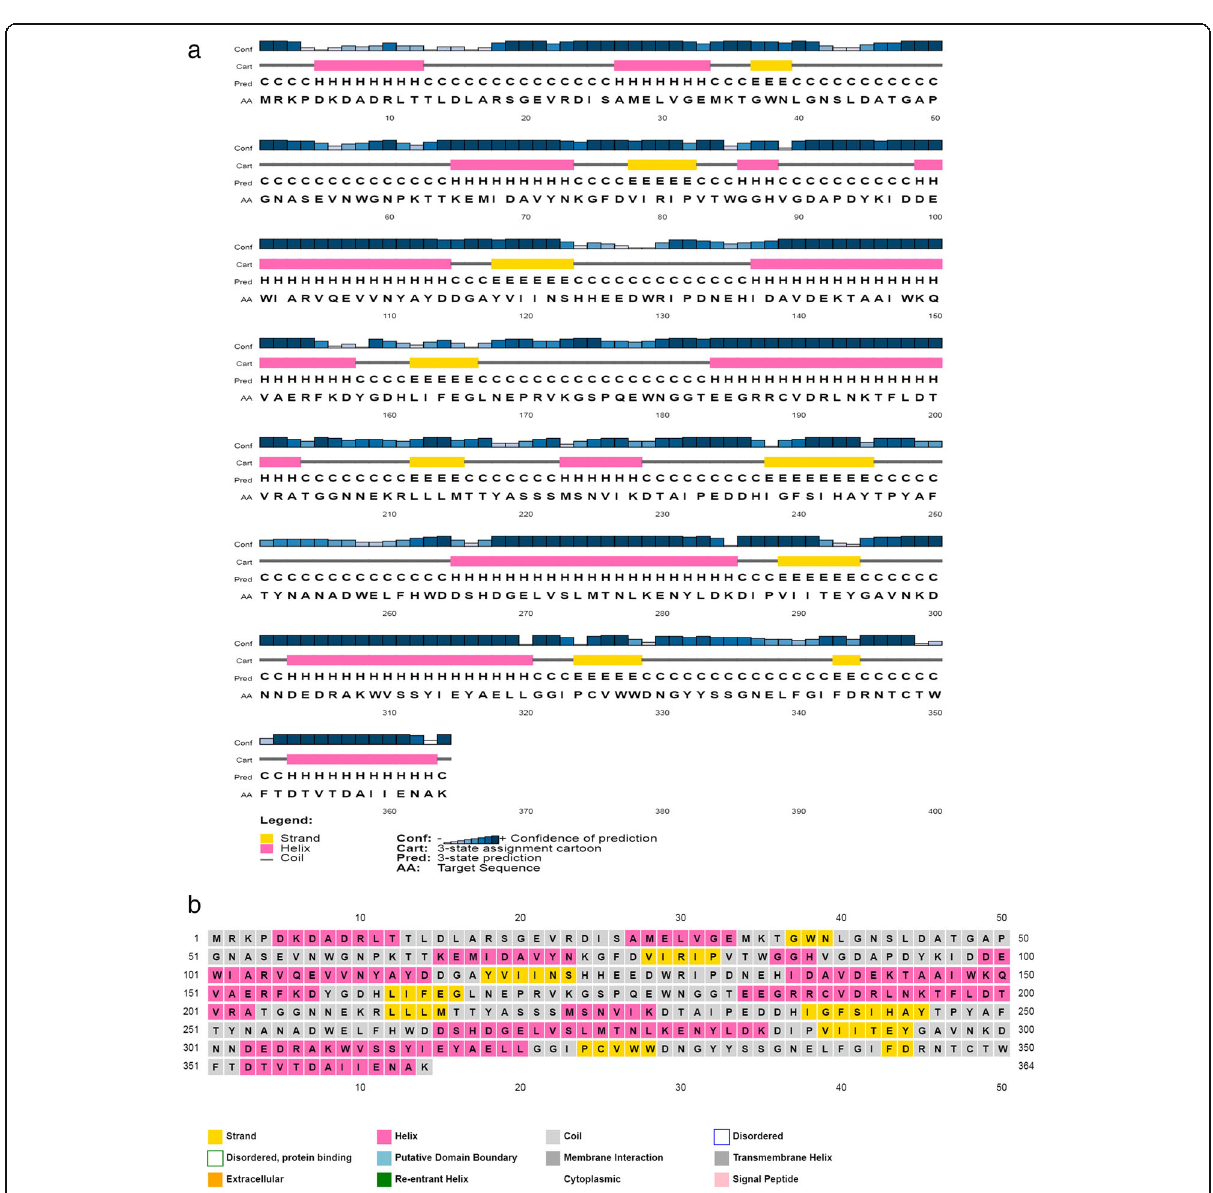
Fig. 3 Secondary structure map ( a ) and graphical representation of the predicted secondary structures present within the protein P23660 ( b ) attained by PSIPRED (The pink blocks represent the alpha helices; the yellow blocks represent beta strands, and the black thread-like structures were the coils. The confidence of prediction observed throughout the predicted secondary structure was quite high, indicating high reliability of the